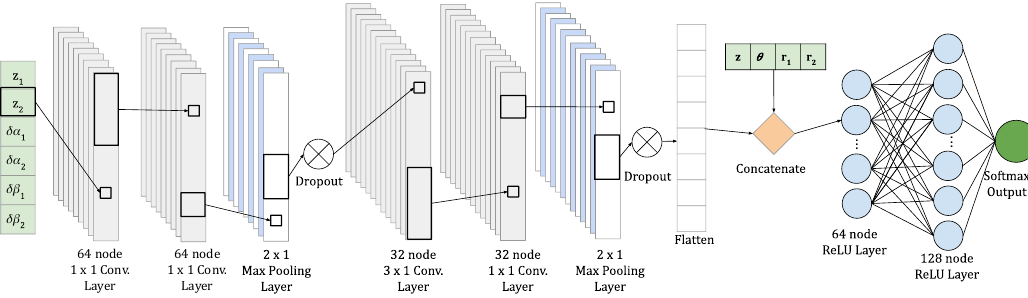
Figure 6. Diagram of 1D CNN for classification of toy model particle lists. When used, XAUG variables are concatenated to the processed outputs immediately before the final two ReLU